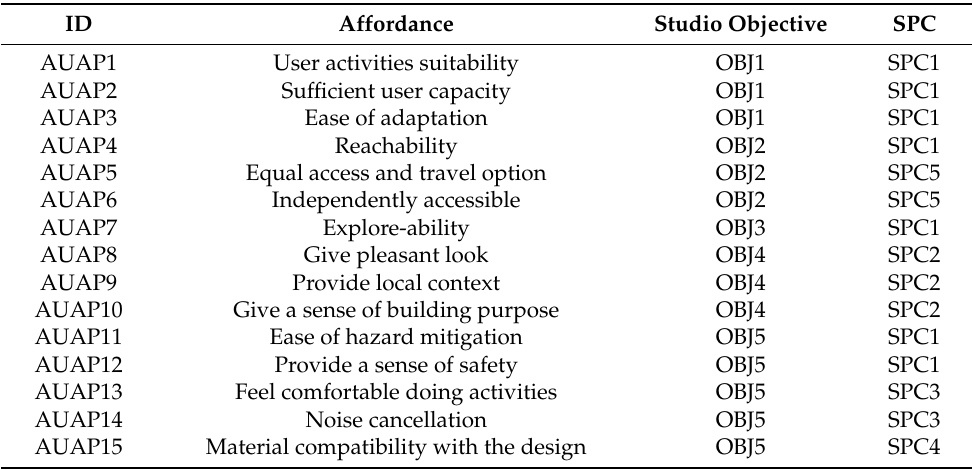
Table 3. List of affordances mapped to affordance structure